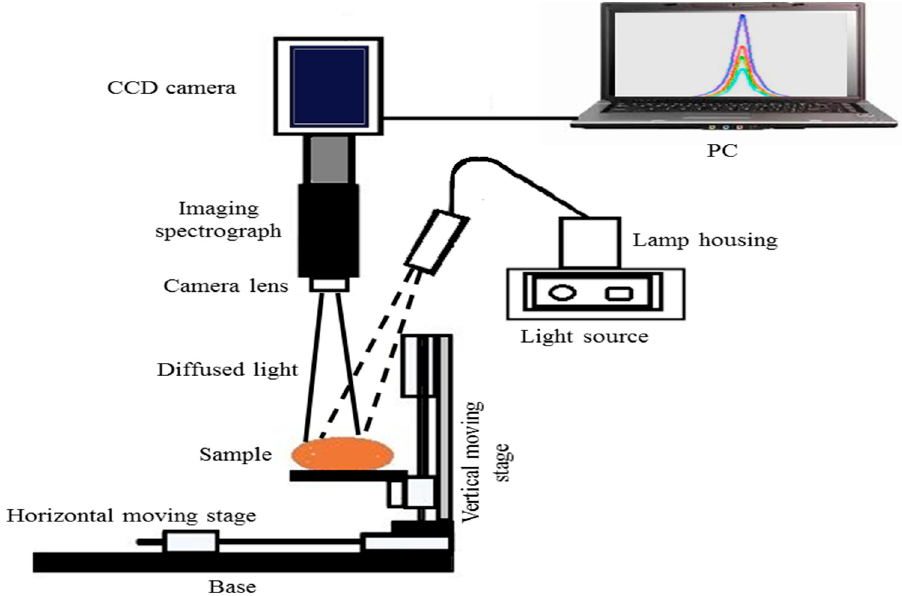
Figure 2. Schematic representation of the VIS/NIR hyperspectral reflectance system used to test whole FL1879 and R.Burbank potato cultivars.